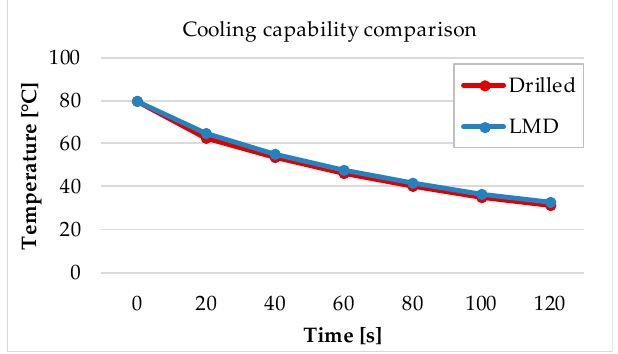
Figure 10. Cooling capacity comparison between the drilled and the LMD channels.